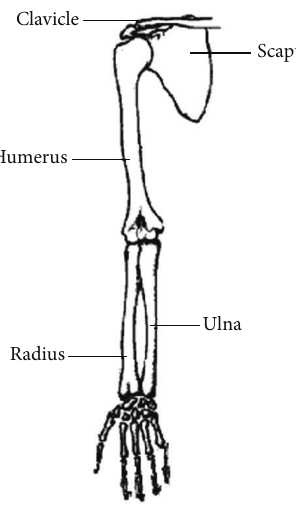
Figure 1: Humerus bone in human arm.